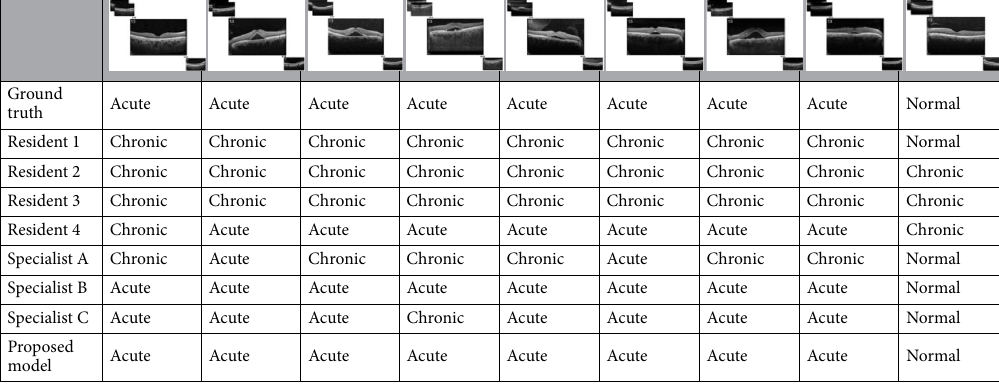
Table 3. Examples of consensus and non-consensus cases between residents, specialists, and our models. Acute Acute central serous chorioretinopathy, Chronic Chronic central serous